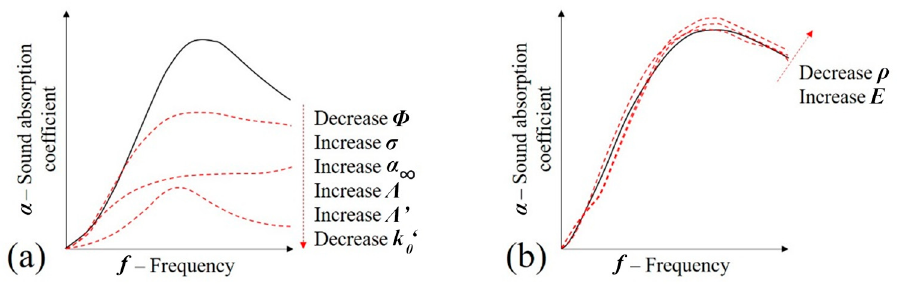
Figure 17. Combination of changing parameters in the sound absorption of porous media due to the effect of ( a ) rigid structure (JCAL model) and ( b ) poroelasticity (Biot’s theory).